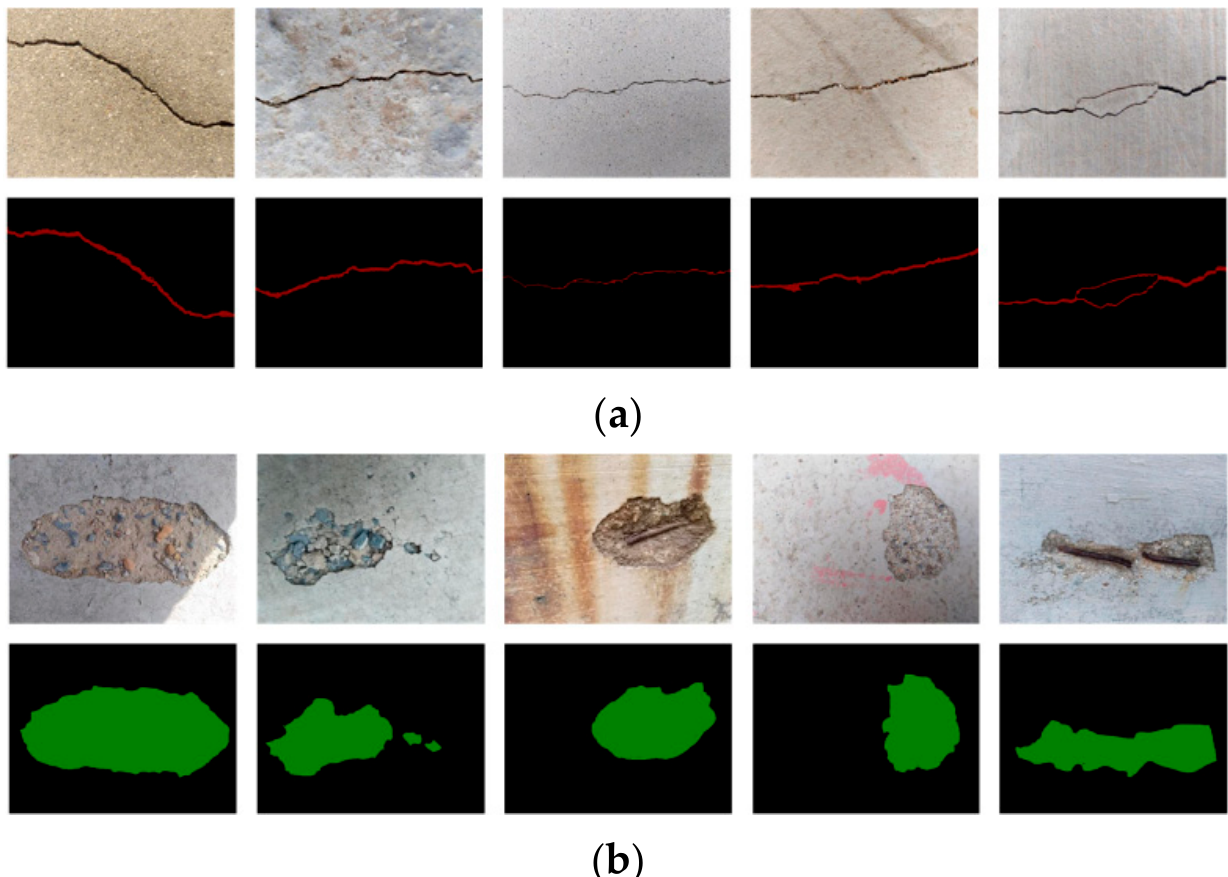
Figure 2. Examples of damage images and their labels in built database: ( a ) crack and ( b ) spalling.